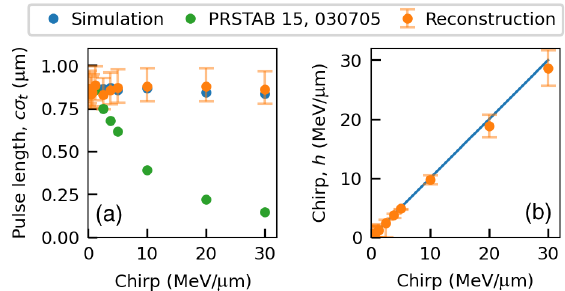
FIG. 2. Results for a scan of the e-beam chirp in 1D simu- lations. The left and right show the x-ray pulse length and e-beam chirp, respectively, as obtained from the simulation (blue), from our reconstruction model (orange), and from the model of [15]